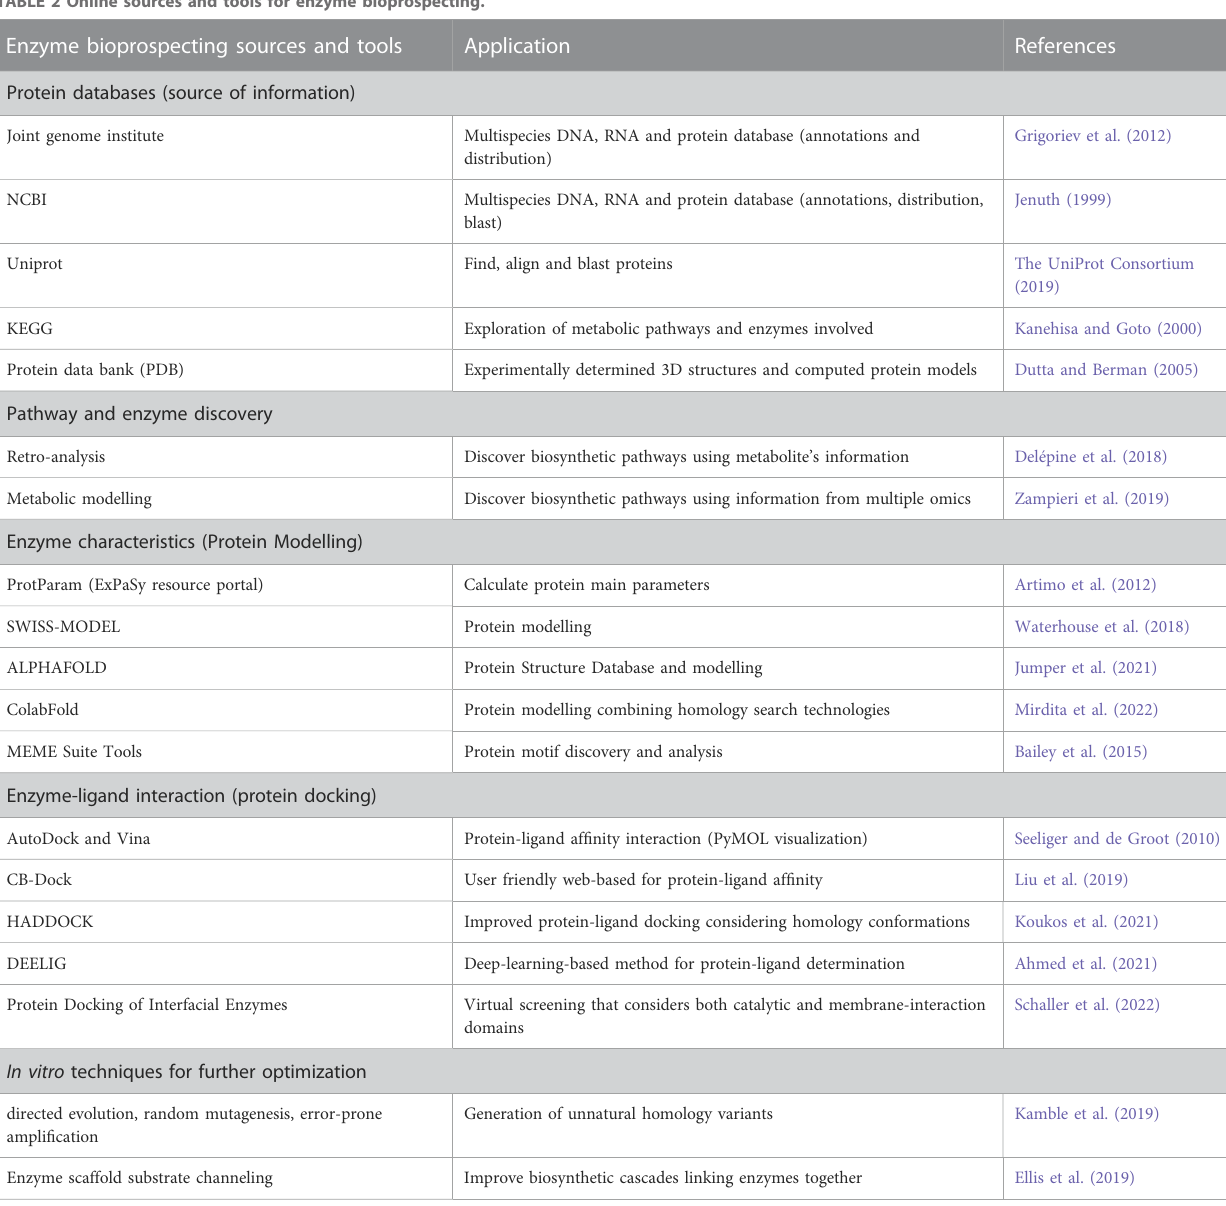
Enzyme characteristics (Protein